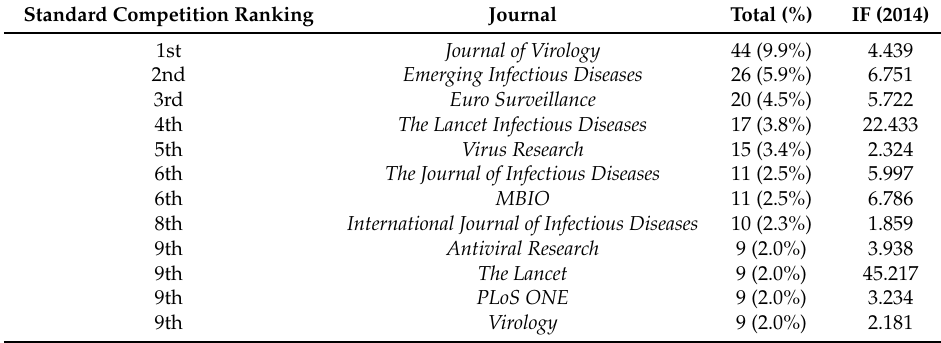
Table 2. Ten most productive journals (with impact factors (IF)) with MERS articles during the period from 2012 to 2015.